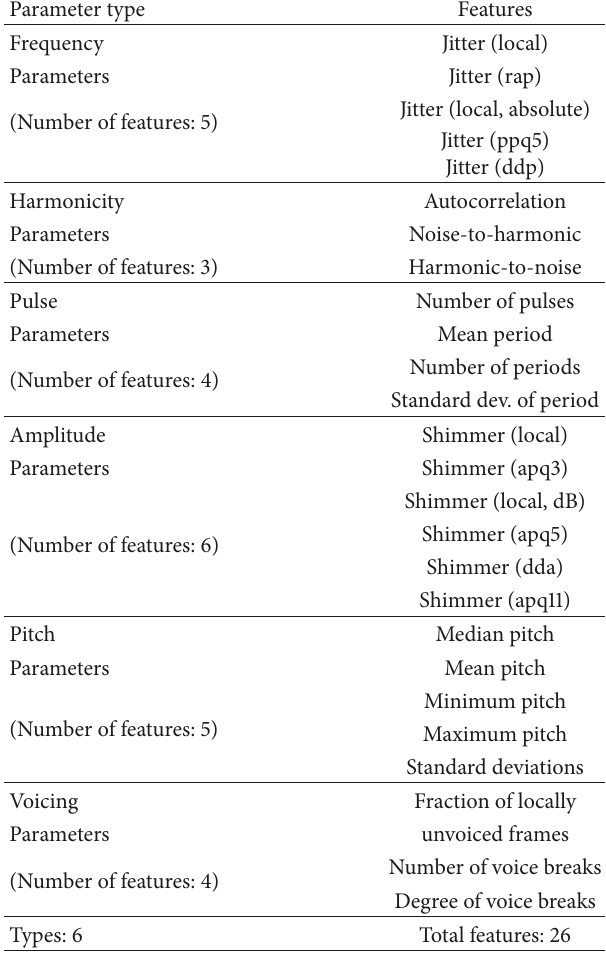
Table 1: Time frequency features.